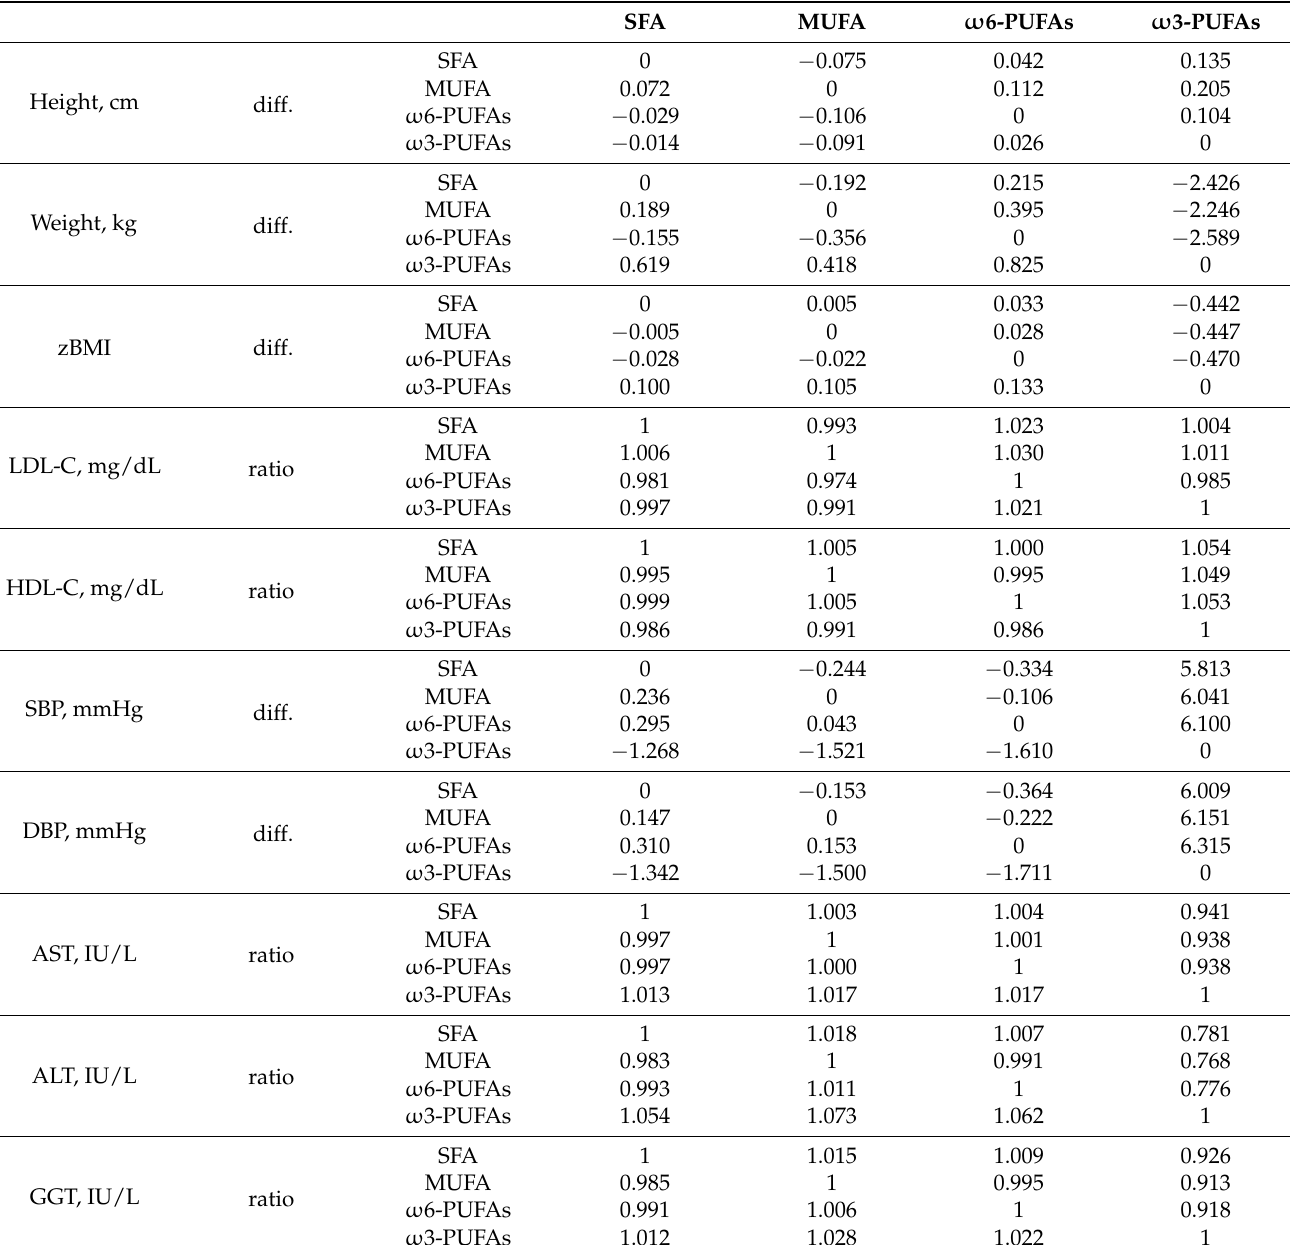
Table 5. Change matrix for a 4% compositional substitution of column fatty acids with row fatty acids. SFA MUFA ω 6-PUFAs ω 3-PUFAs